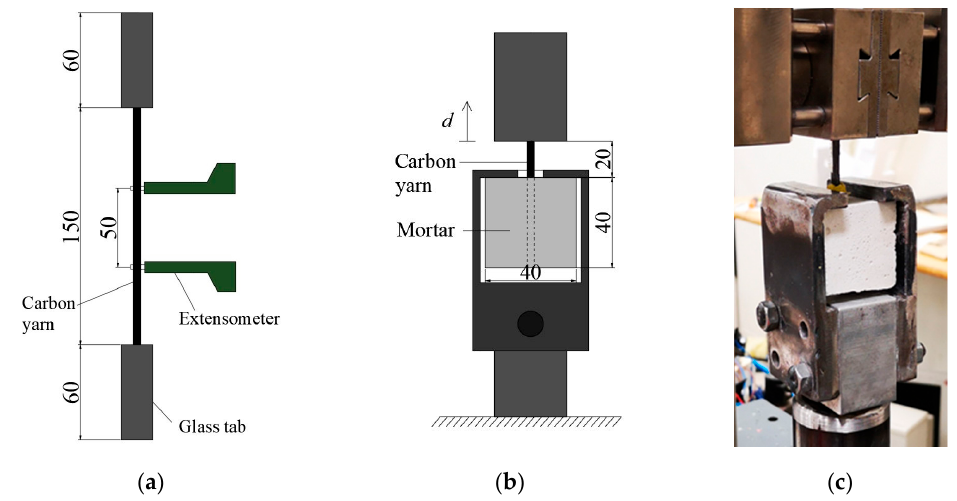
Figure 2. ( a ) Tensile and ( b ) pull-out test layout, ( c ) actual pull-out test setup. Pull-out tests were carried out on carbon yarns embedded in a cubic specimen of cementitious mortar (40 × 40 × 40 mm 3 ). The free length is kept constant and equal to 20